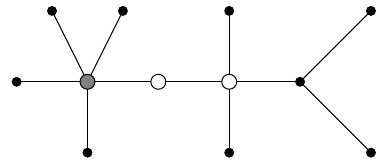
Figure 1: Central nodes implied by eigenvector centrality (gray) and mean occupation layer (white) may